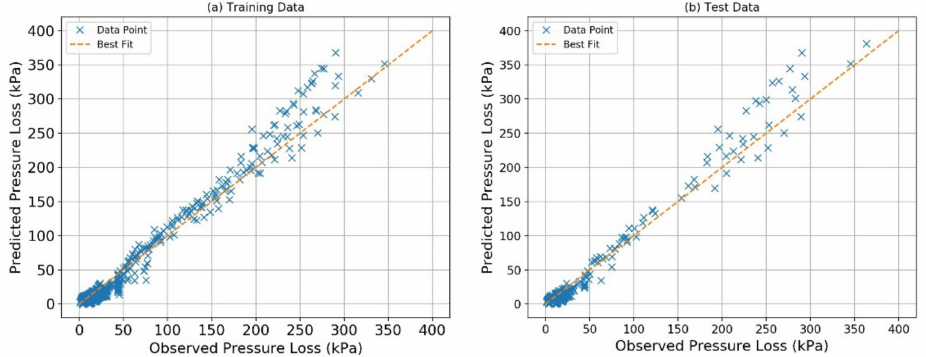
Figure 2. Artificial neural network (ANN) predicted pressure plotted with observed pressure loss: ( a ) training dataset and ( b ) test